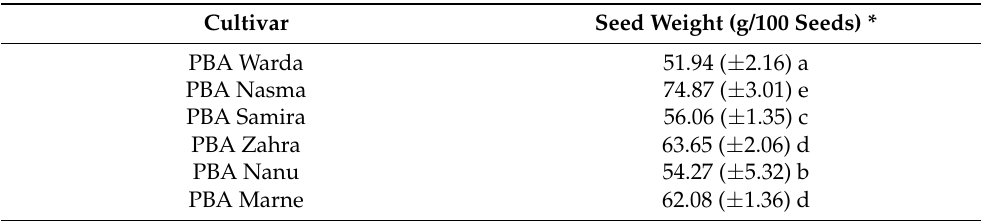
Table 10. The seed weight (g) of six faba bean